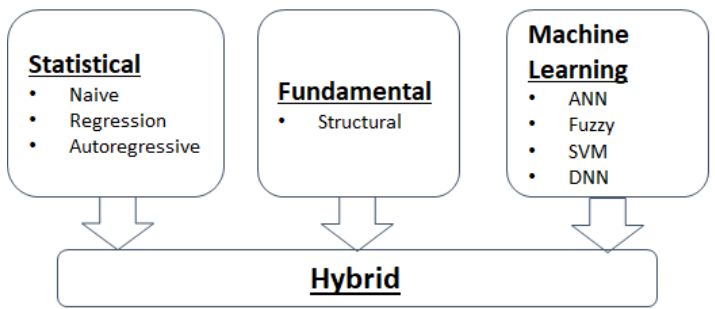
Figure 2. Diagram of electricity price forecasting method